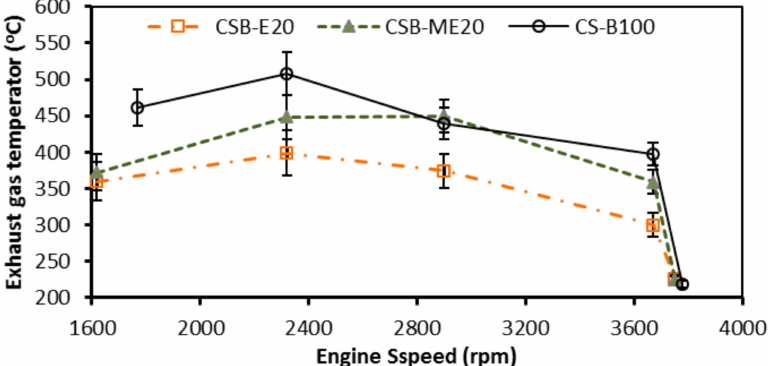
Figure 11. The relationship between engine speeds (rpm) and exhaust gas temperature ( ◦ C) for CS-B100, CSB-E20 and